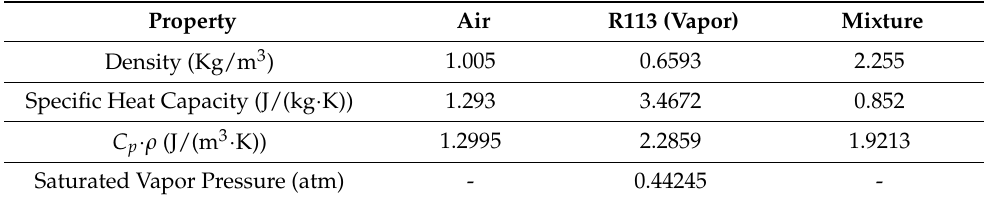
Table 5. Physical properties of air mixed with saturated R113 vapor at 25 ◦ C and 1 atm (absolute